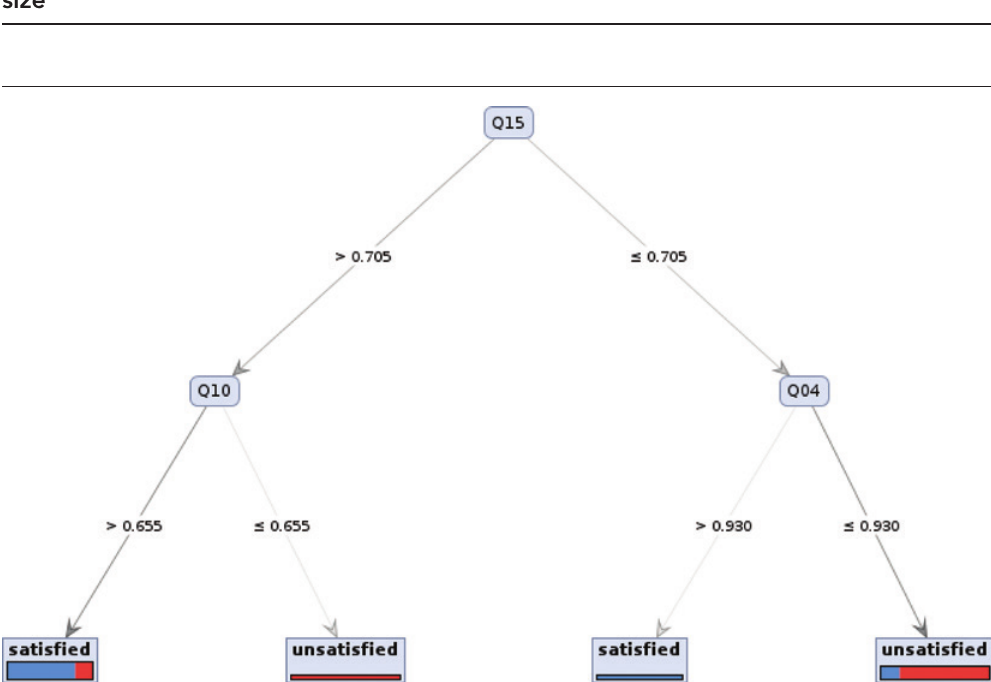
Figure 8: AI-generated tree model showing how Q22 satisfaction can be predicted from other NSS questions, in computer science, across the bottom half of providers by